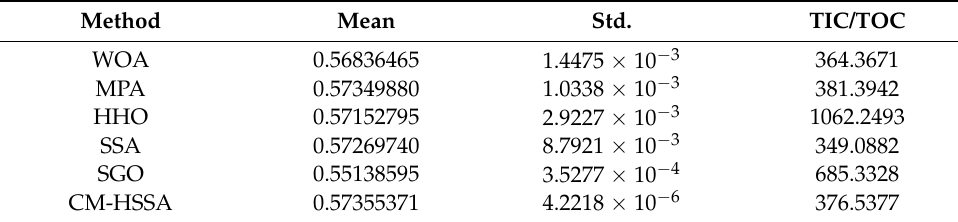
Figure 24. Iterative trajectories of six algorithms for Problem 3. Table 8. Comparison of optimization results for Problem Table 8. Comparison of optimization results for Problem 3.